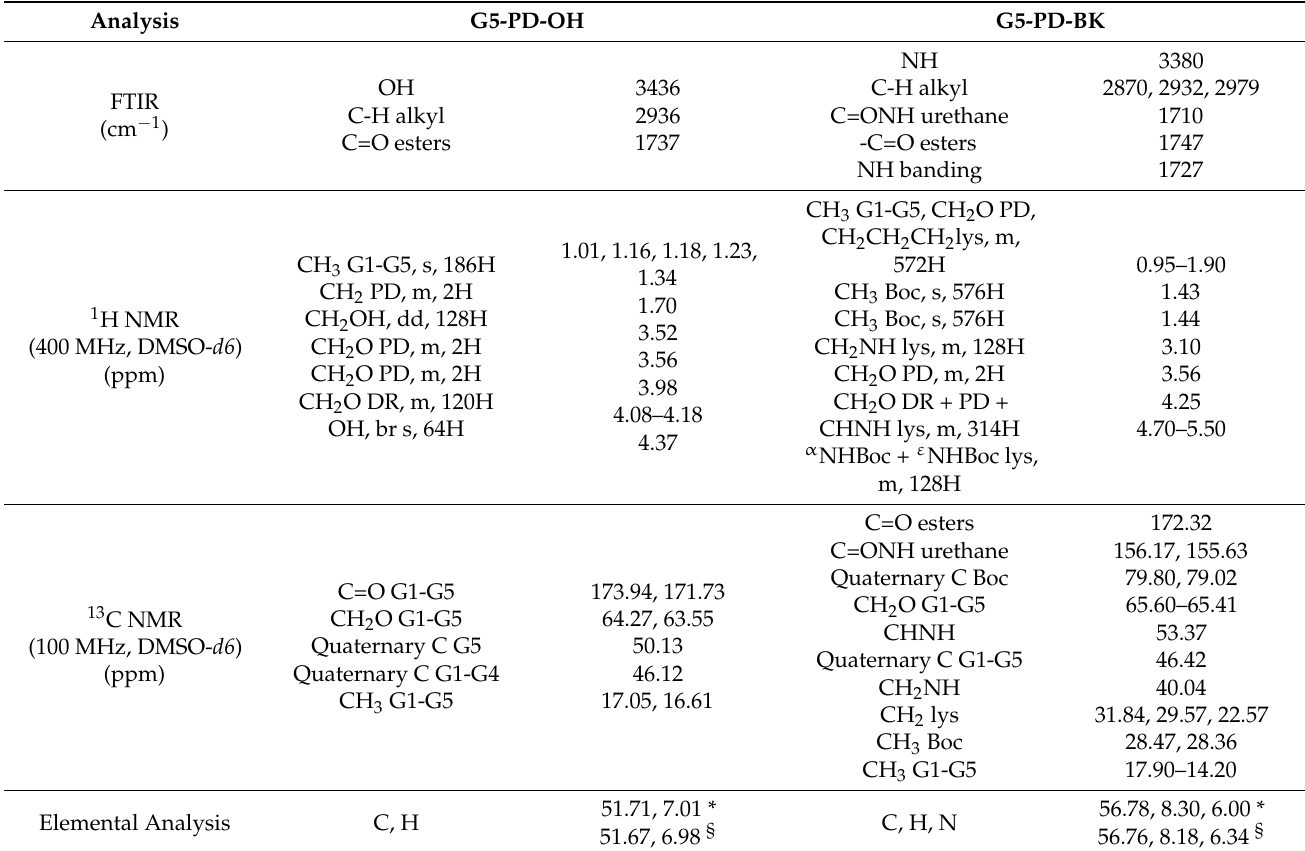
Table 1. Main physicochemical features of G5-PD-OH and G5-PD-BK.